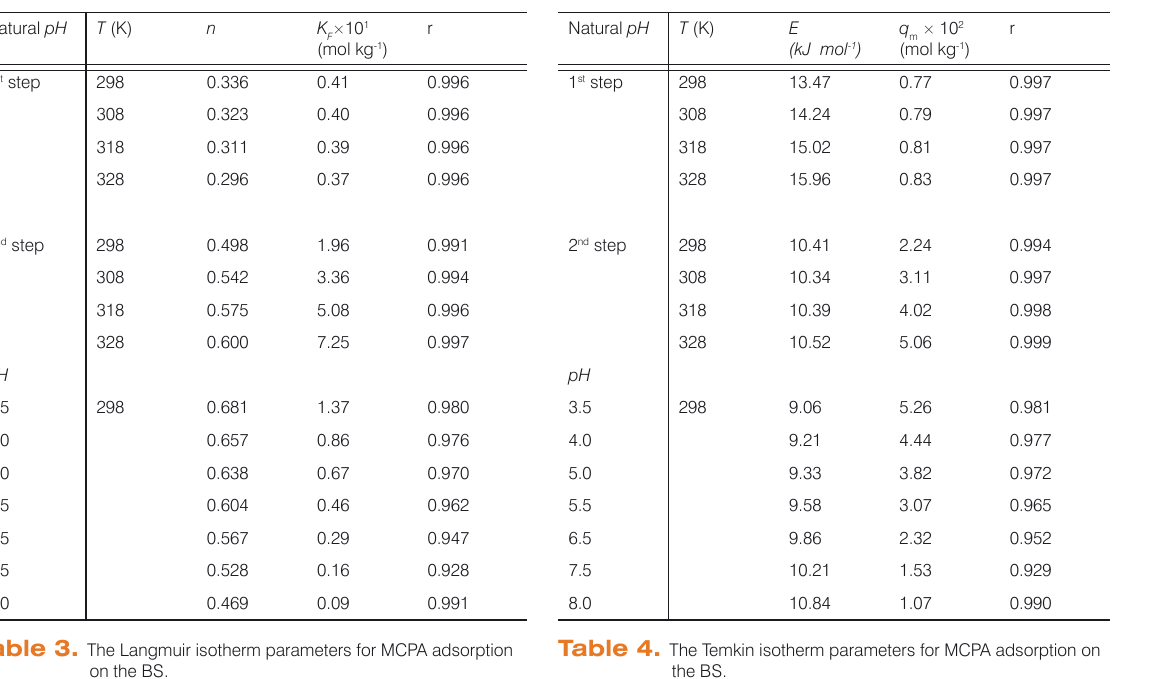
Table 1. The Freundlich isotherm parameters for MCPA adsorption on the BS.